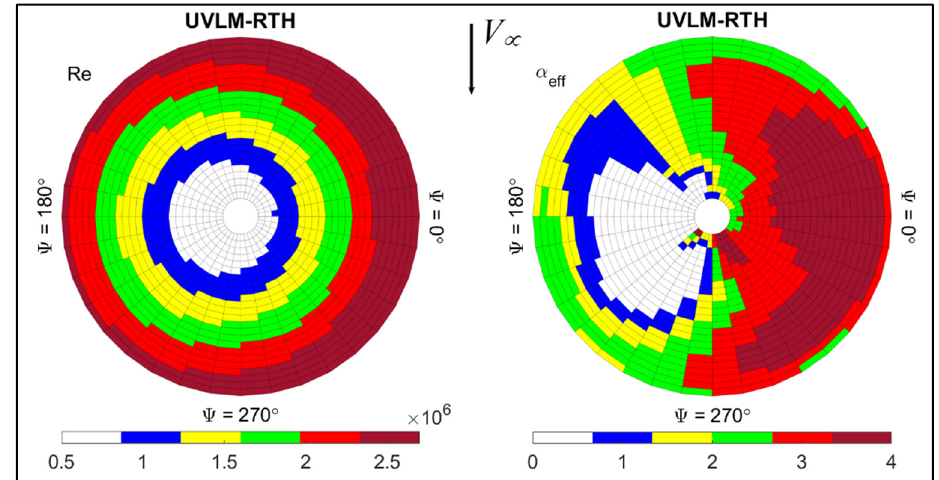
Figure 20. Contours of steady state Re and α eff for the modified Bell 429 tail rotor in forward flight obtained using UVLM-RHT.